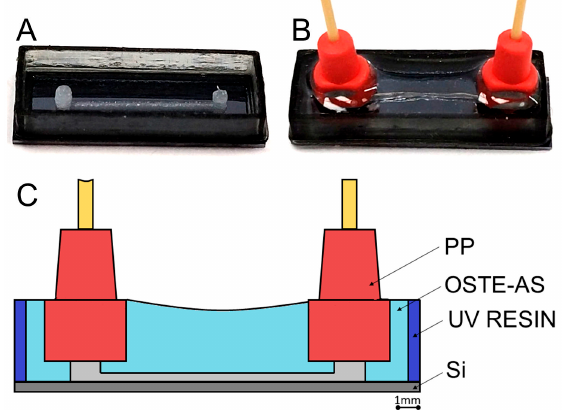
Figure 8. Formation of a microfluidic system on a silicon wafer: ( A ) preparation of a sacrificial layer; ( B ) finished microfluidic system; ( C ) cross section of the microfluidic system.